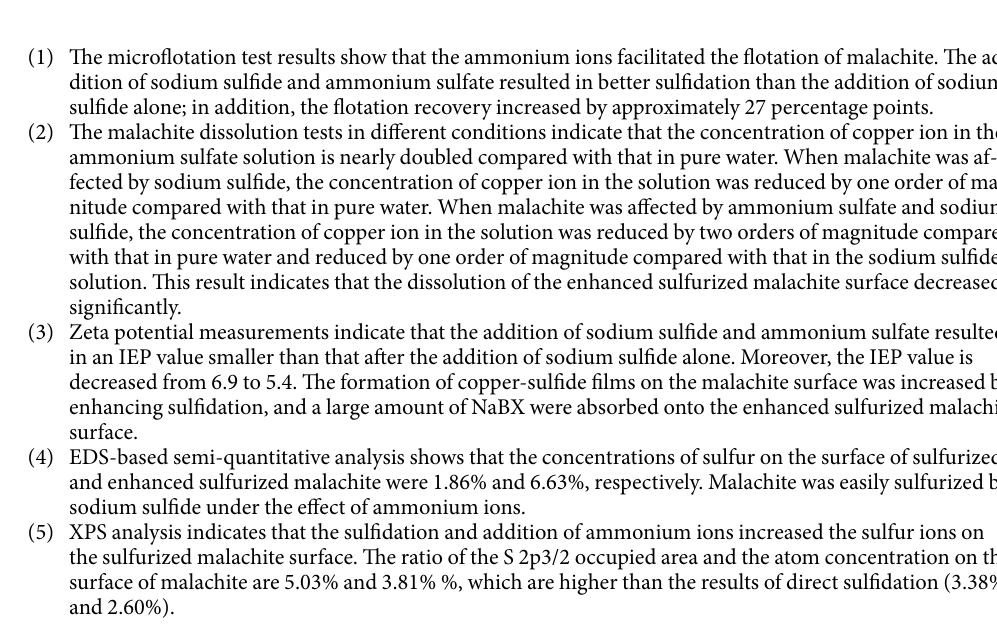
Figure 5. S 2p spectra of malachite after ( a ) sulfidation and ( b ) enhanced